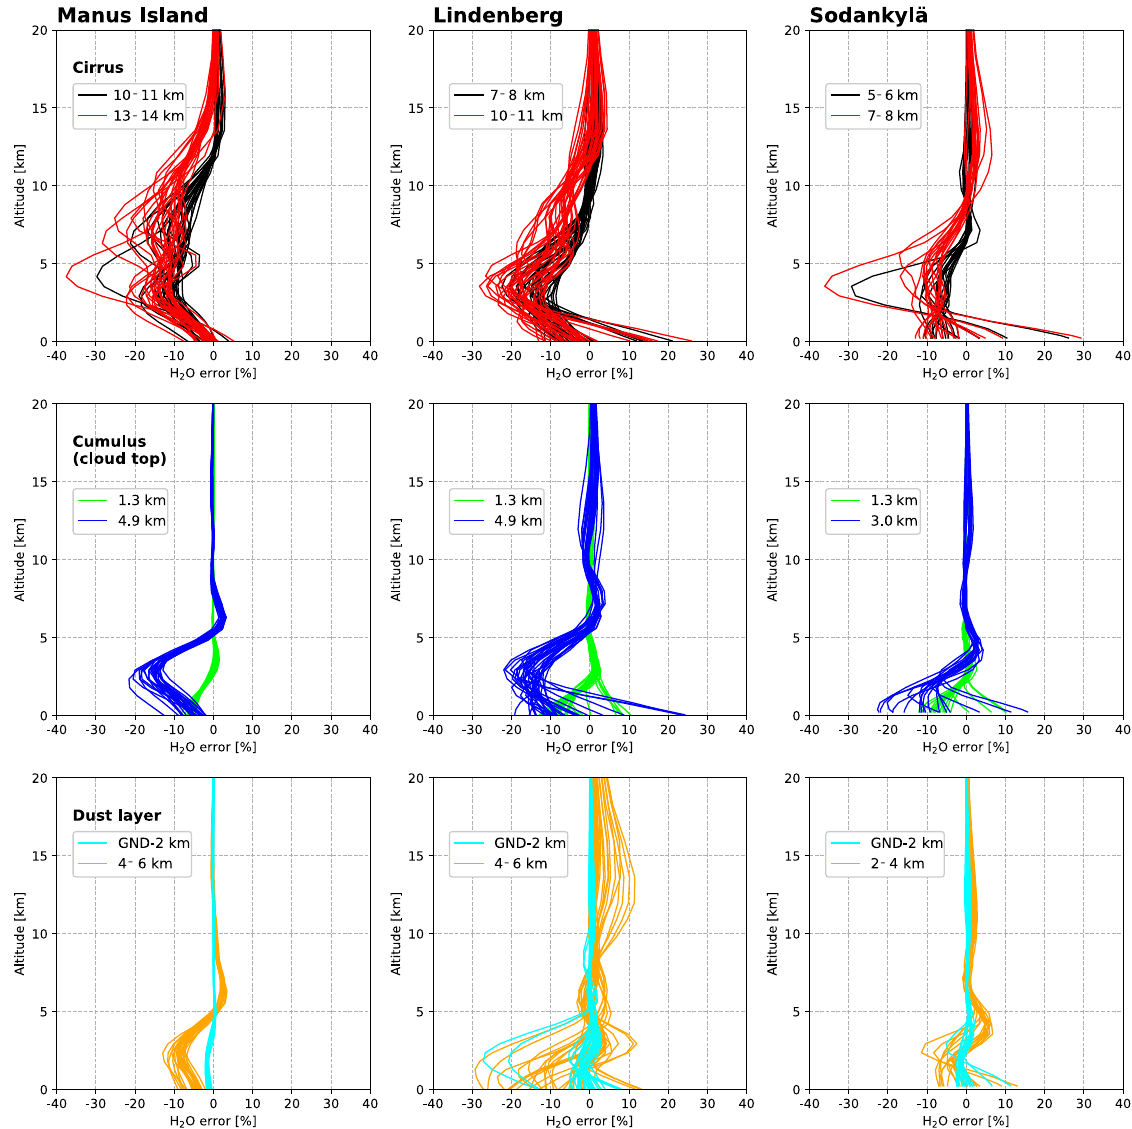
Figure 9. Same as Fig. 8, but for errors due to unrecognized clouds: cirrus (50% fractional coverage; for the location of cloud layers, see legend), cumulus (10% fractional coverage with cloud top altitudes as given in the legend), and mineral dust (homogeneous dust clouds layers as give in the legend and with the composition according to OPAC